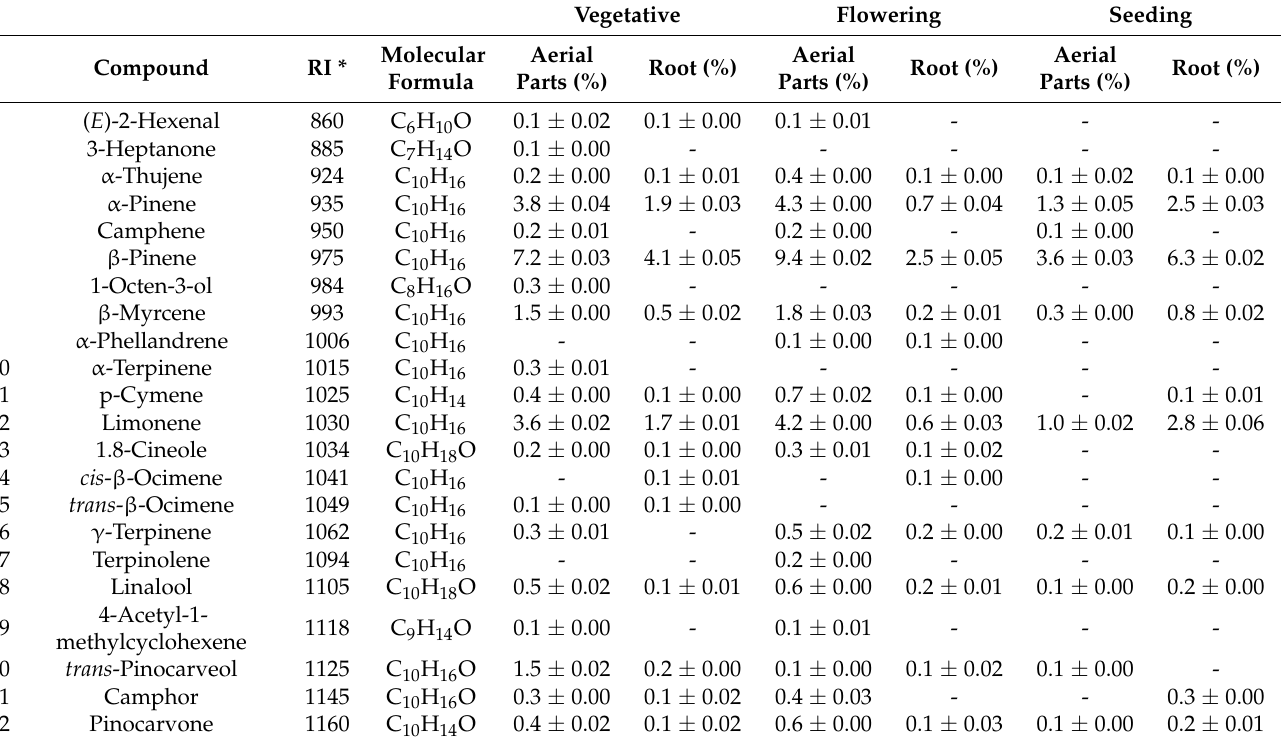
Table 1. The content ( n = 3) of the volatile hydrocarbons identified and determined in the T. polium extracts of the aerial parts and root of this plant collected at different phenological stages. The exemplary GC-MS chromatogram is given in the Supplementary Materials (Figure S1). Vegetative Flowering